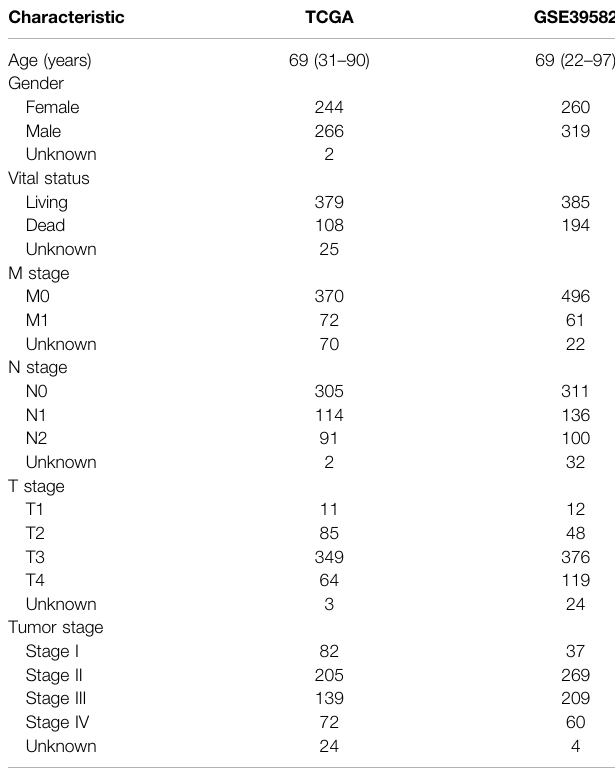
TABLE 1 | Summary of patient demographics and clinical